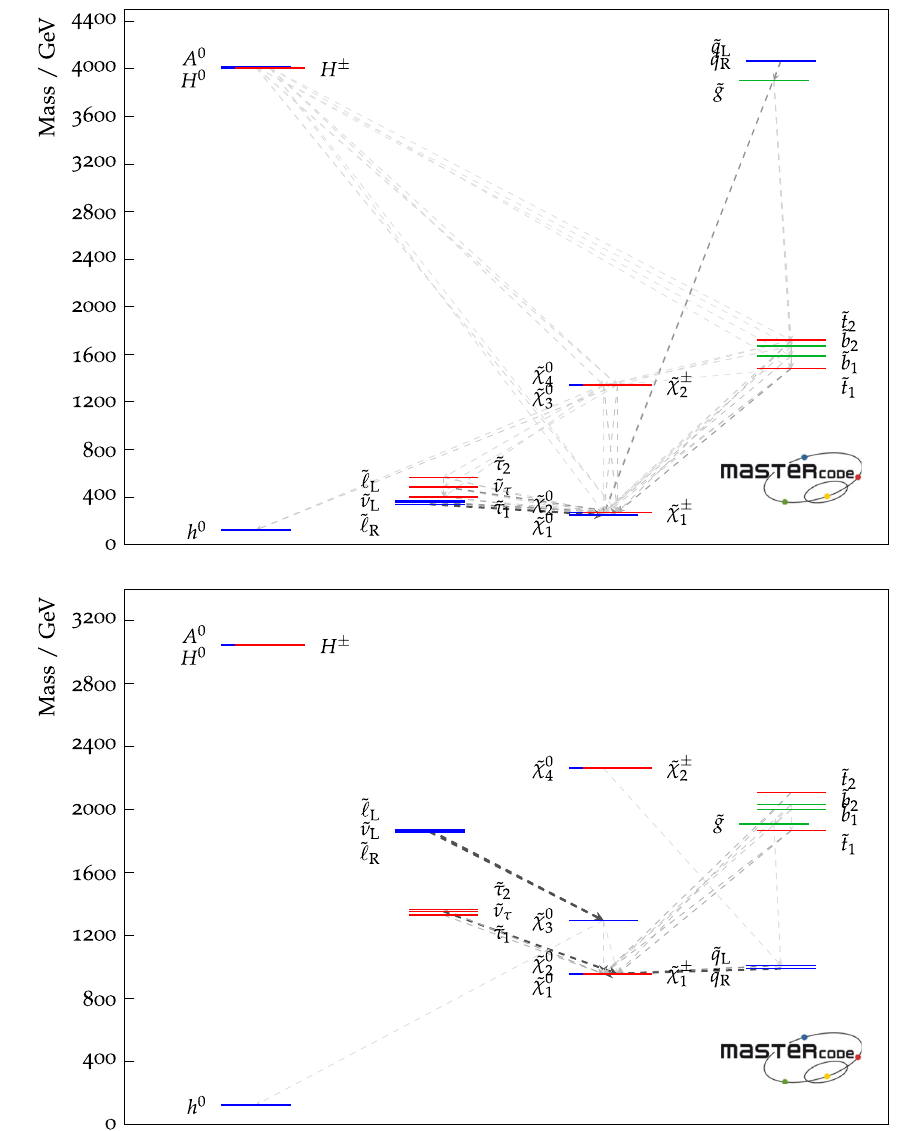
Fig. 1 Higgs and sparticle spectra for the best-fit points for the pMSSM11 with (top) and without the ( g − 2 ) μ constraint (bottom), showing also decay paths with branching ratios > 5%, the widths of the lines being proportional to the branching ratios. These